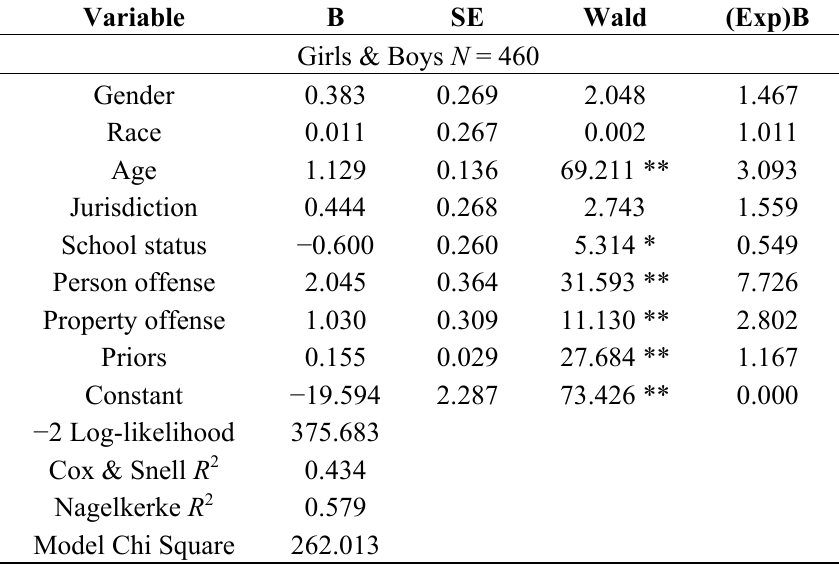
Table 2. Logistic Regression Results for Judicial Waiver of Girls and